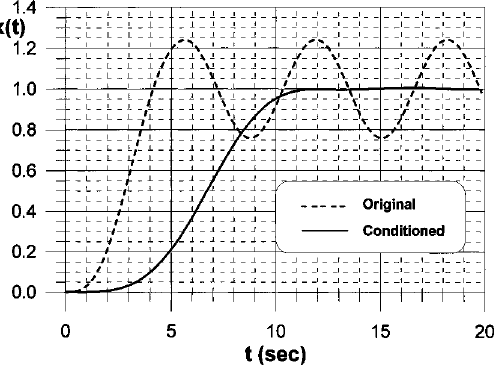
Fig. 10. System response to the original and conditioned guidance functions ( ! = 1 rad/s, all other variables set equal to